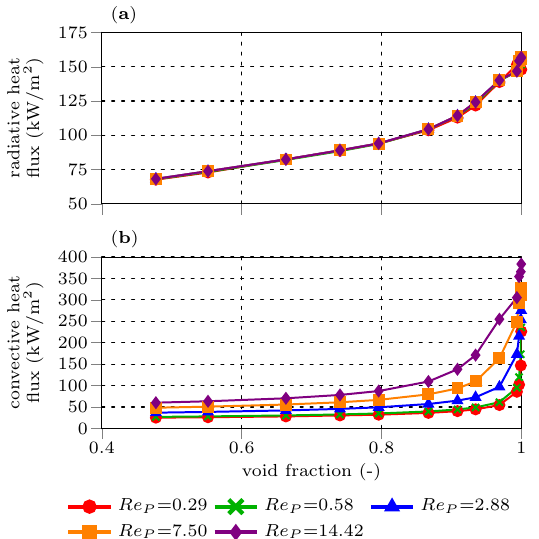
Figure 7. Comparison of specific radiative ( a ) and convective ( b ) integral heat flux towards the particle cluster versus the cluster void fraction for different particle Reynolds numbers ( Re P ).